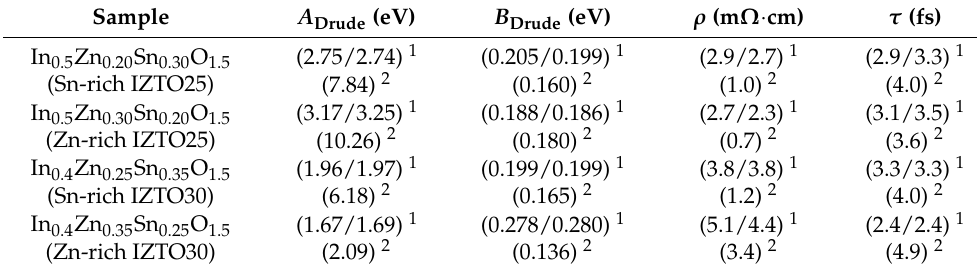
Figure 5. Extinction coefficient, k , as a function of wavelength in near–mid-infrared part of spectra for as-deposited and annealed non-stoichiometric IZTO samples obtained using Drude oscillator. Notice different scales for as-deposited and annealed samples. Table 3. Parameters A (typical error ± 0.03 eV) and B (typical error ± 0.002 eV) for simple Drude oscillator (see Equation (3)) obtained from the best fit of ellipsometry data and calculated specific electrical resistivity, ρ , and free carrier mean free time, τ (see Equation (3)), for non-stoichiometric IZTO films deposited onto glass and SiO 2 /Si substrates and annealed non-stoichiometric IZTO films onto glass